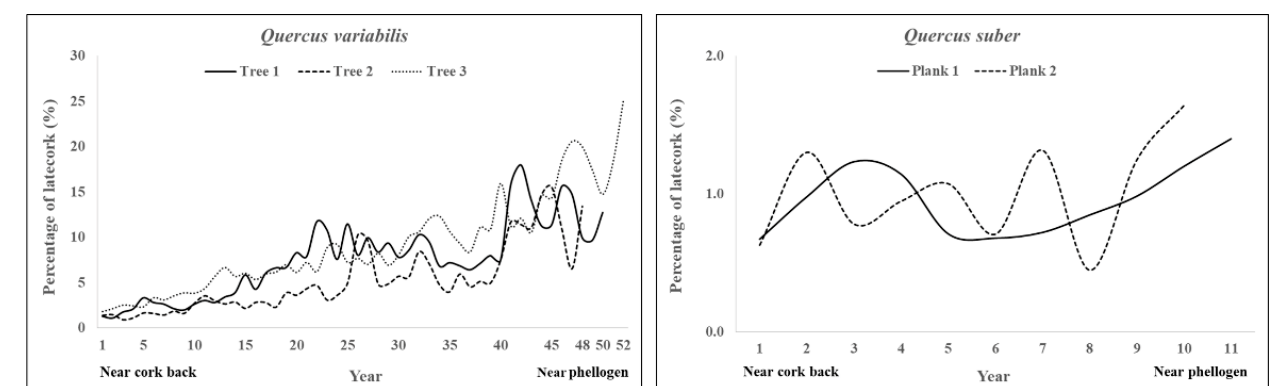
Figure 4. Variation of latecork percentage from the cork back to the phellogen in Q. variabilis virgin cork and Q. suber reproduction cork.